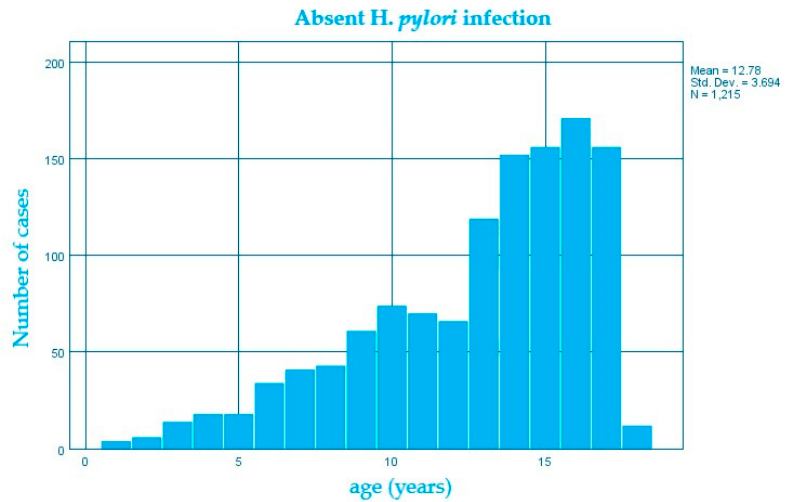
Figure 1. Structure of the group of patients without H. pylori infection by age (years). Table 1. Average age of diagnosis of infection with H. pylori